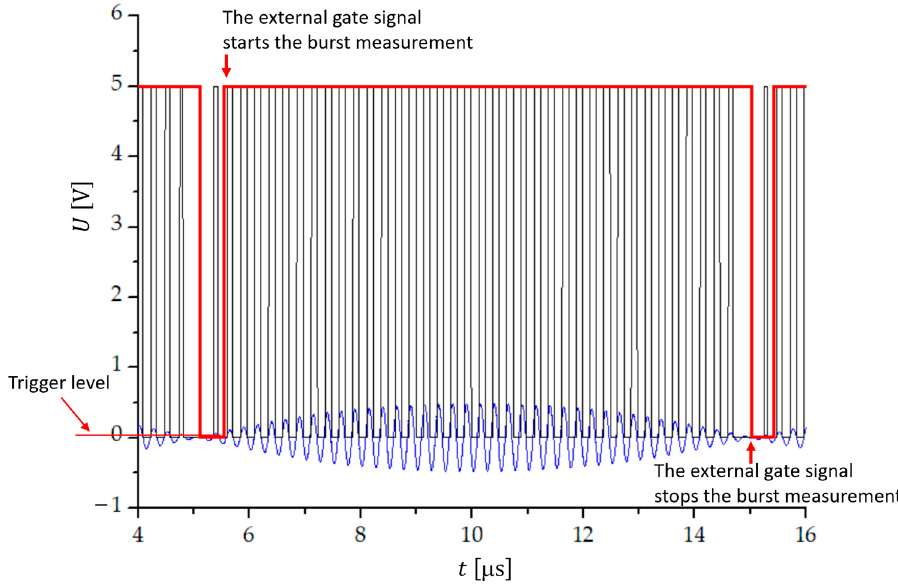
Figure 3. Temporal sequence of signals when the number of transitions through zero within one beat period is counted with the help of an external gate signal. The measuring time is synchronized with the first transition through zero of one beat period and trigger level of 0.5 mV.